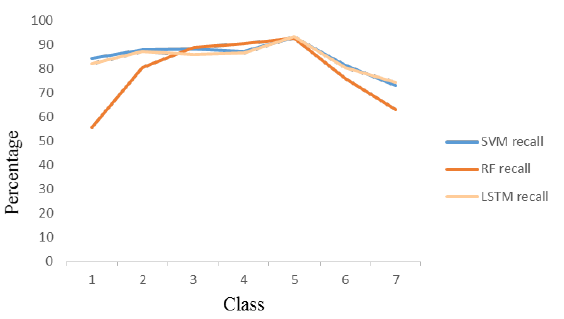
Figure 9: Total accuracy variation for different V b , with V f = 50